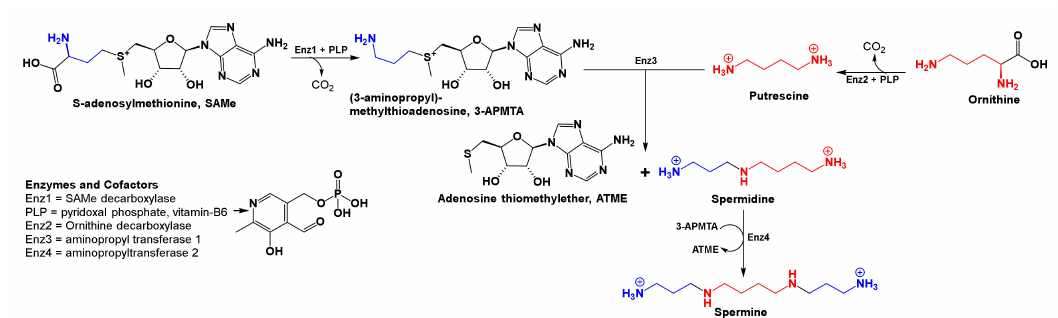
Figure 6. Spermidine and spermine biosyntheses. A high concentration of these amines was found in the hippocampi, and frontal, dorsolateral prefrontal, and temporal cortices of MD patients who completed suicide. This figure outlines the biosyntheses of spermidine and spermine from SAMe and ornithine. Two SAMe molecules donate the aminopropyl groups (blue) and ornithine donates a diaminobutane fragment (red). Reactants, enzymes, cofactors, and byproducts involved in these biosyntheses are shown in this figure